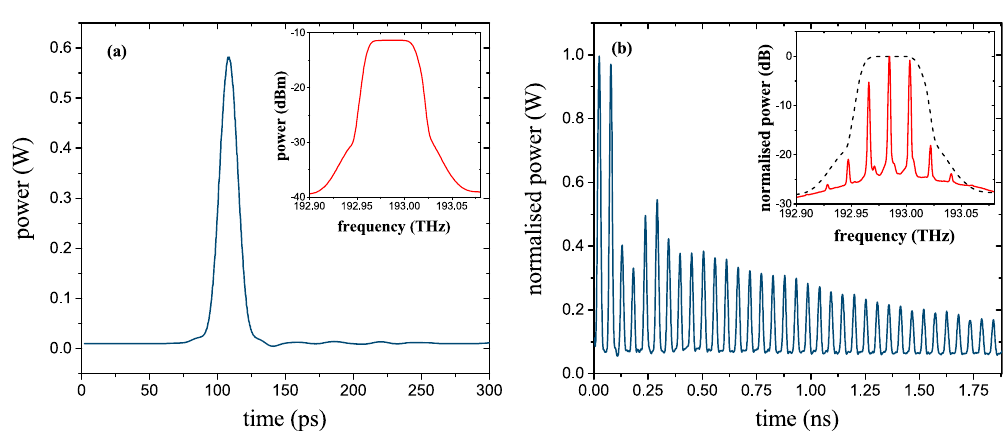
Figure 3. Time and frequency domain (insets) representation of the signal at the input ( a ) and output of the ring ( b ). The input signal ( a ) is a pulse train with a repetition rate of 100 MHz (10 ns), produced by an Erbium- doped, mode-locked fibre laser and bandwidth limited to 60 GHz by a waveshaper (inset in ( a )). Frequency lines are carved out from the signal spectrum by the transfer function of the ring (inset in ( b )). Since the finesse of the ring is finite and due to losses, the ring produces copies for around 2 ns. The amplitude behavior of the copies after the ring is defined by the ring parameters and the input power but not by the input signal. Hence, it can be equalized by post-processing of the data. Please note from the inset in ( b ) that new frequency lines outside the original spectrum (dashed line) cannot be seen. Thus, the ring does not lead to any visible nonlinear optical